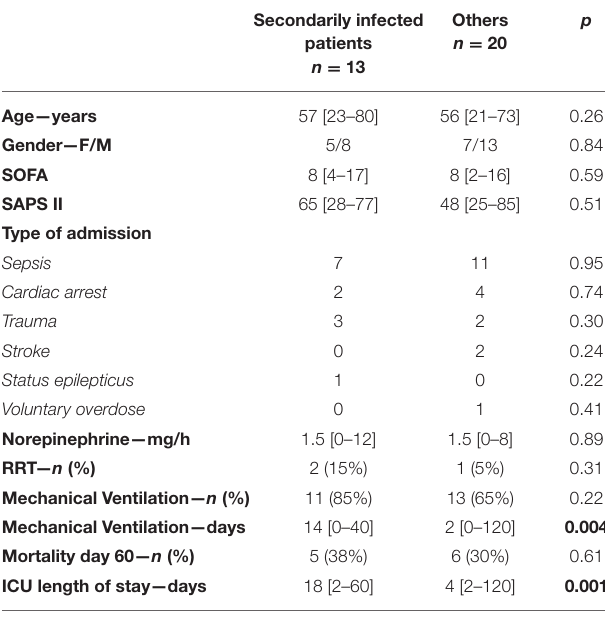
TABLE 2 | Patient characteristics, SOFA < 8 vs. SOFA ≥ 8. TABLE 3 | Patient characteristics, secondarily infected vs. others.